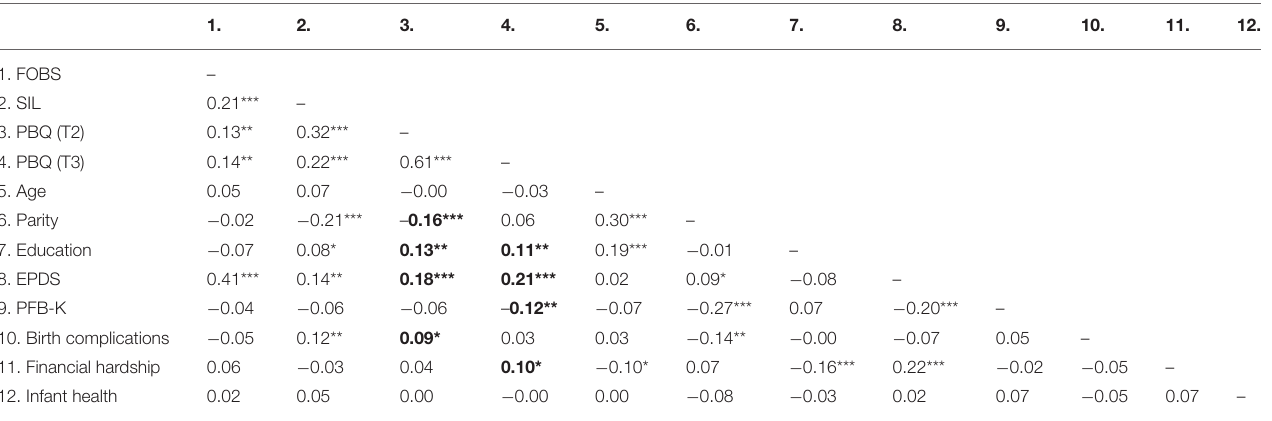
TABLE 2 | Correlation matrix including the predictor, mediator, outcome, and potential confounders.